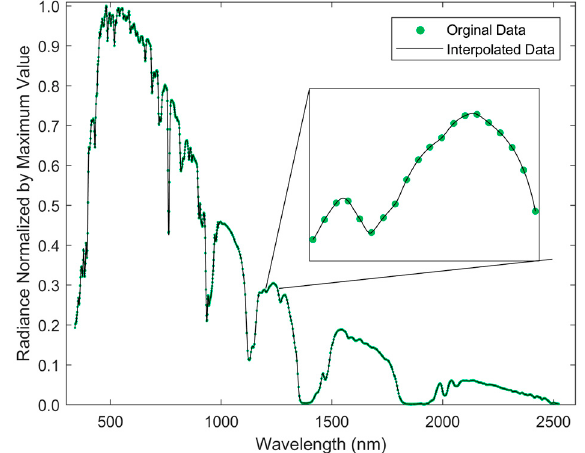
Figure 9. Averaged and normalized ground spectrum of asphalt before and after interpolation. The differences between the two curves can be seen in the subplot, which zooms in on the 1185–1255 nm spectral window. The interpolated curve, R ( λ ) , was used for the methodologies described in Section 2.3. The mean squared error between overlapping data points before and after interpolation was negligible (<10 − 30 ). The Akima interpolation method generated a qualitatively smooth R ( λ )